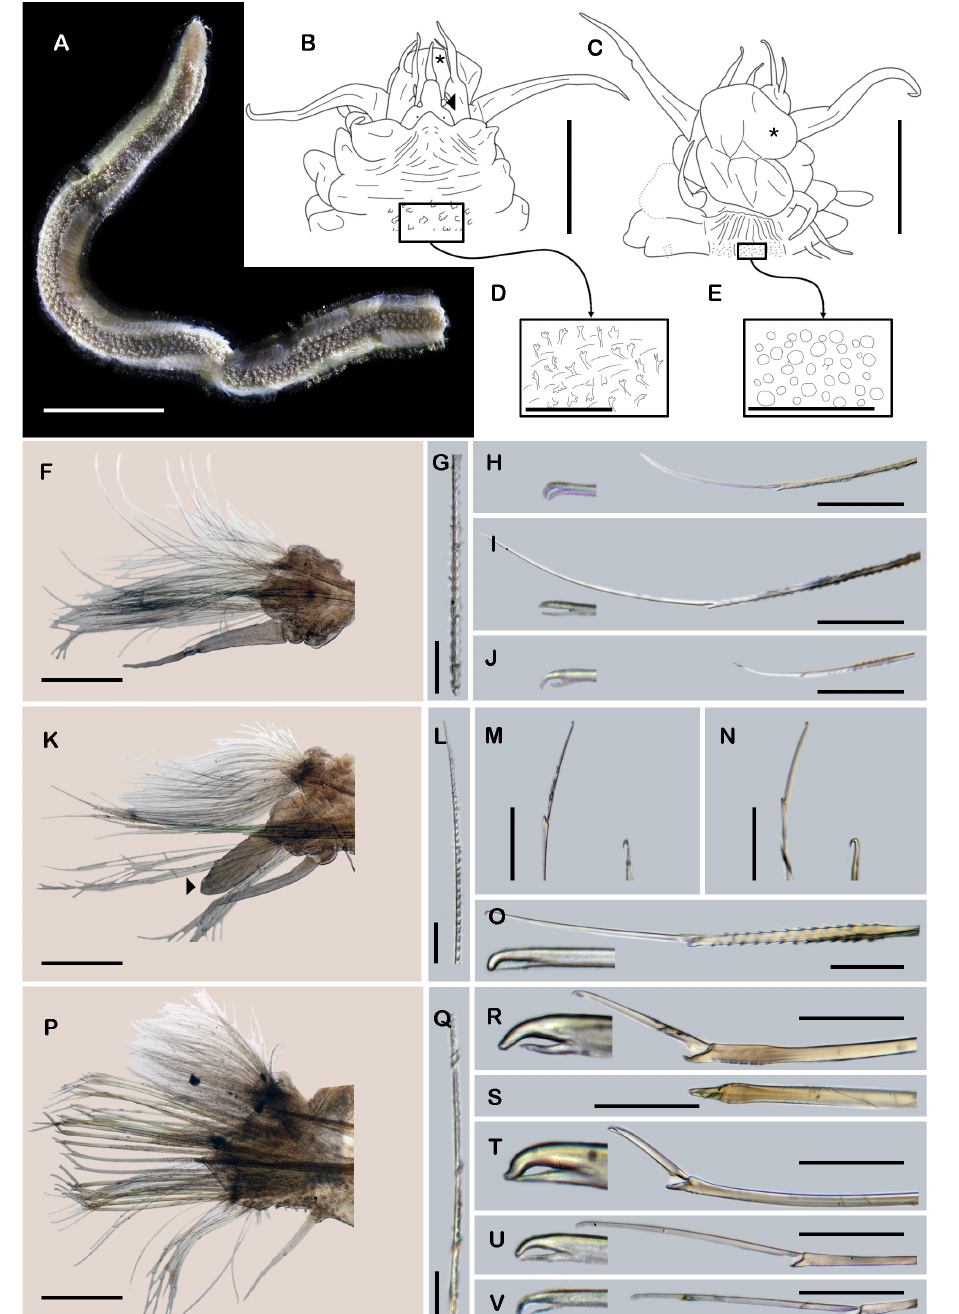
Fig. 5. Hartmanipsamolyce pettiboneae sp. nov., holotype (UMML 22.1087). A . Incomplete worm, dorsal view. B . Anterior end, dorsal view; arrowhead indicates ctenidia; asterisk indicates partially everted pharynx. C . Anterior end, ventral view (close-up in box); asterisk indicates partially everted pharynx. D . Dorsal papillae (close-up in box). E . Ventral papillae (close-up in box). F . Right parapodium from segment II. G . Notochaeta from same. H . Unit A. I . Unit B. J . Units C and D. K . Right parapodium from segment III, arrow indicates neuropodial lobe. L . Notochaeta from same. M . Unit B. N . Units C and D. O . Unit A. P . Right parapodium from segment 81. Q . Notochaeta from same. R . Unit A. S . Unit B. T . Unit C. U . Subunit 2. V . Unit D. Scale bars: A = 1 cm; B–C = 1 mm; D–F, K, P = 500 μm; G, L, Q = 40 μm; H–J, M–O, R–V = 100